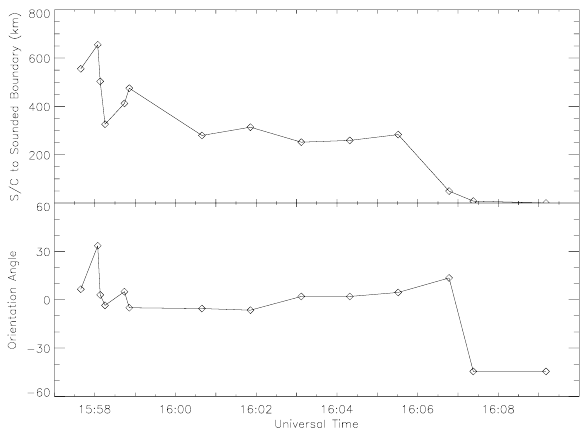
Fig. 7. Using Eqs. (1–2), the distance from the s/c to the sounding boundary (km) and the orientation angle of the boundary is calcu- lated for the entire time the s/c remotely senses the